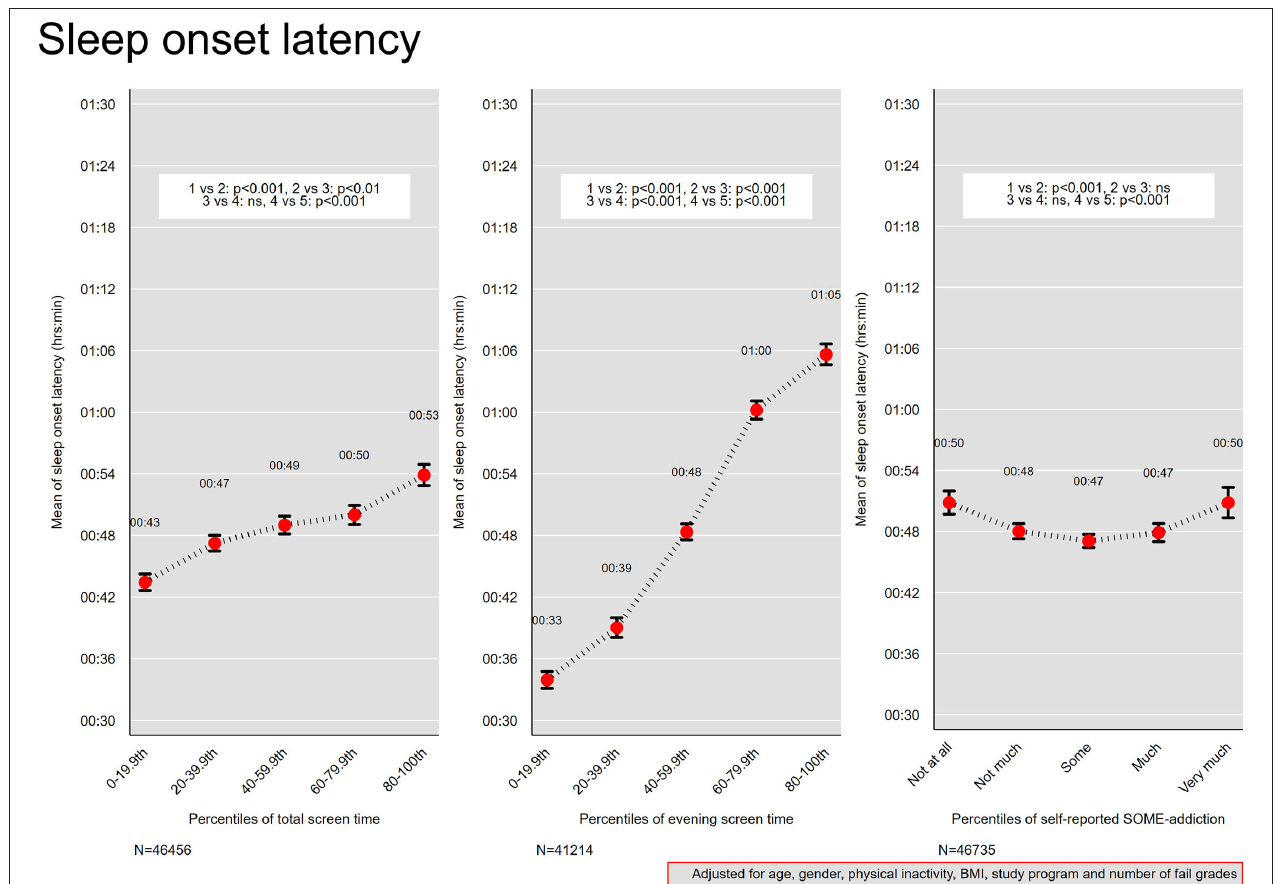
FIGURE 3 | Sleep onset latency. Mean sleep onset latency across quintiles of total screen time and evening screen time, and levels of self-reported social media addiction. Results from linear regression models adjusted for age, gender, physical activity, and body mass index. Bars denote 95 % confidence